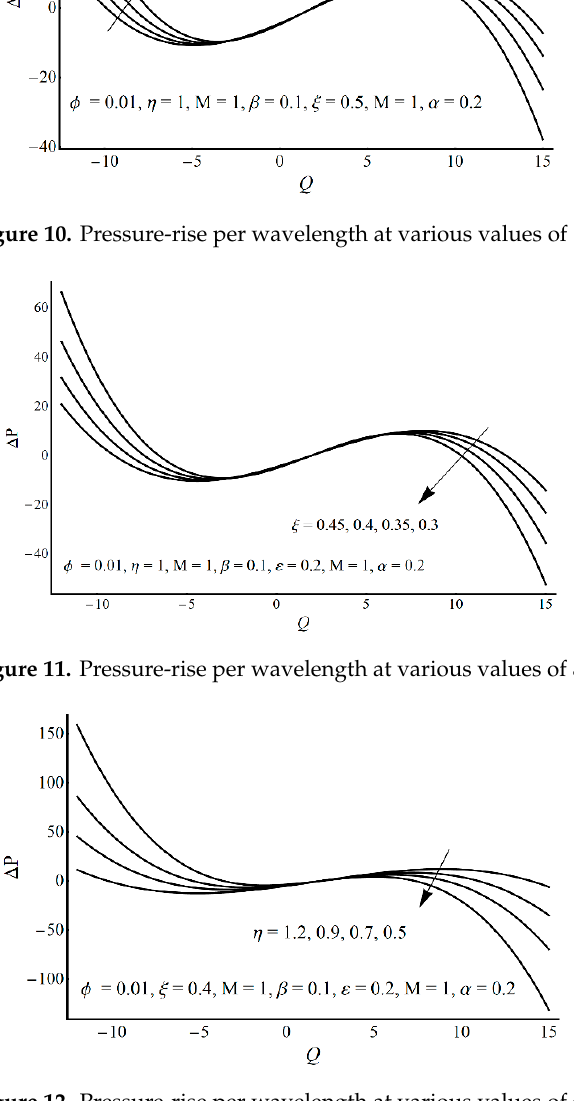
Figure 12. Pressure-rise per wavelength at various values of η .